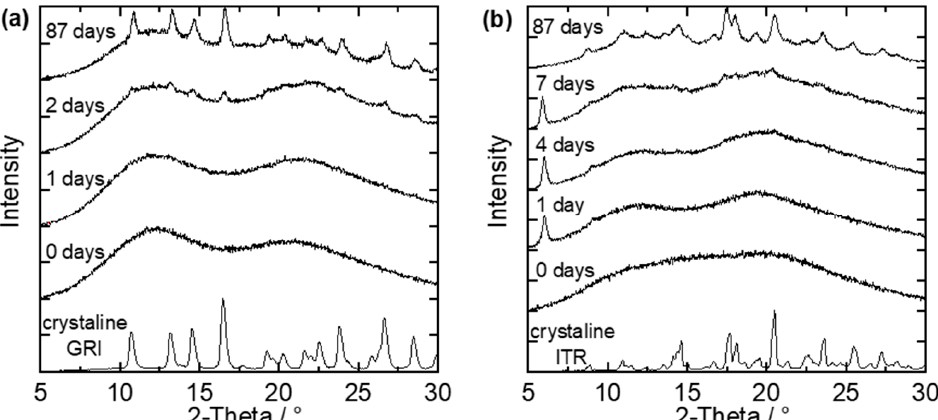
Figure 4. PXRD-diffractograms of ( a ) small particles of a spray-dried GRI/Soluplus ® ASD with 20 wt.% GRI and ( b ) small particles of a spray-dried ITR/Soluplus ® ASD with 40 wt.% ITR stored at 40 °C/75% RH after different days of storage compared to the diffractograms of pure crystalline GRI and ITR.